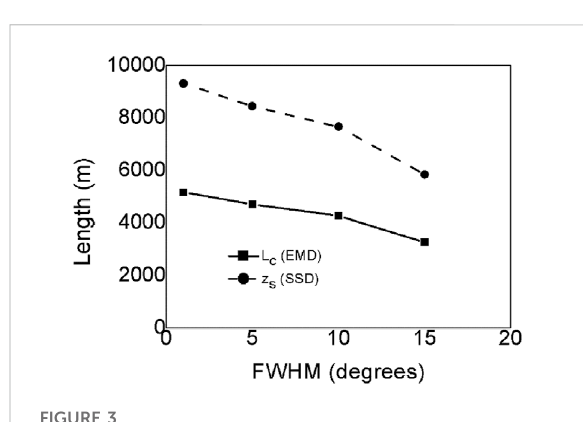
FIGURE 3 Length L c forobtainingtheEMDandlength.z s forestablishing an SSD for each of seven cores of MM MC SOF for different widths of distributions of Gaussian launch